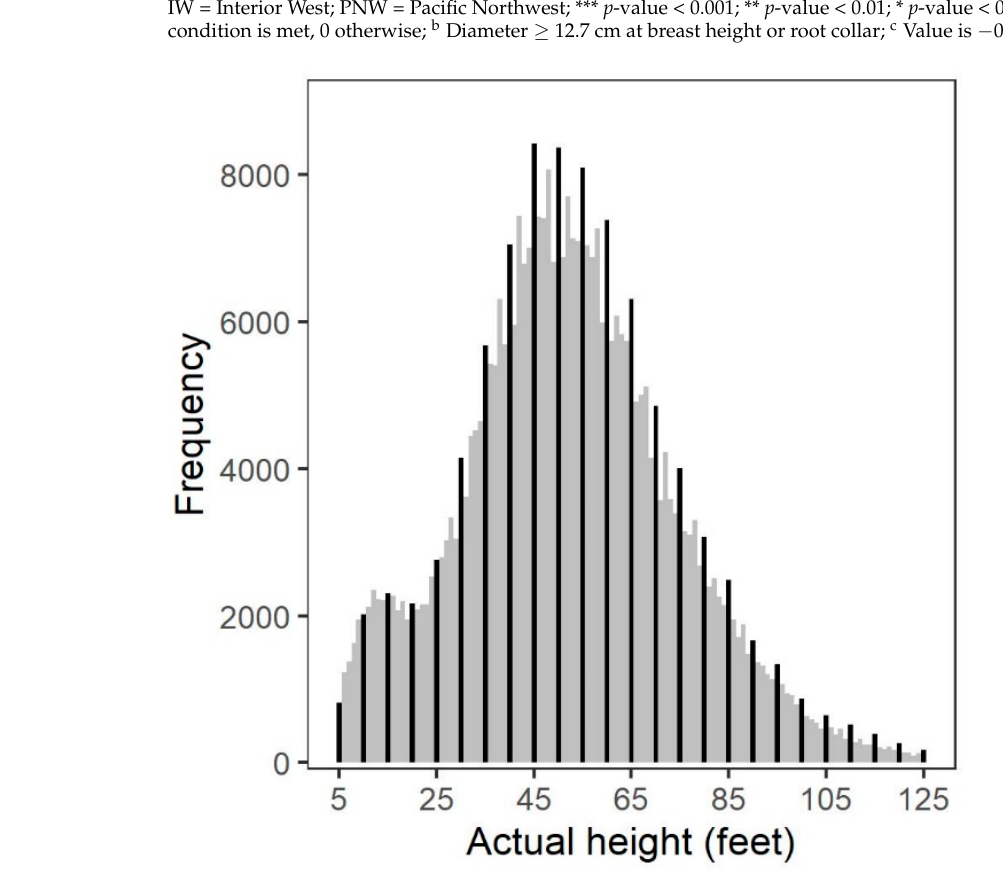
𝑥 + 𝛽 𝑥 + (cid:2869) (cid:2869) (cid:2870) (cid:2870)